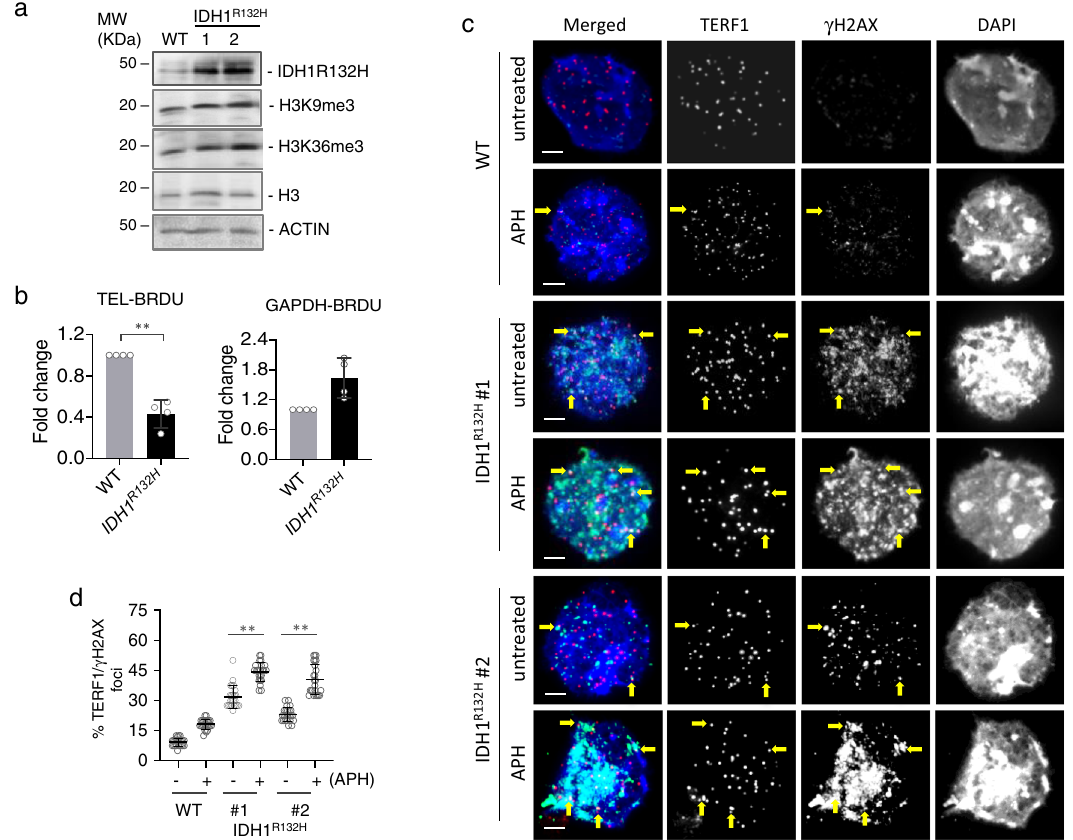
Fig. 5 IDH1 R132H mouse ES cells show replication stress. a Western blot analyses of WT and IDH1 R132H ES cells using antibodies against IDH1R132H, H3K9me3, H3, H3K36me3 and ACTIN. b IP-qPCR analyses of BrdU incorporation at telomeres and Gapdh promoter in WT and IDH1 R132H ES cells ( n = 3 independent experiments). Immuno fl uorescence analyses of TERF1 (red; diluted at 1/500) and γ H2AX (green; diluted at 1/1500) in WT and IDH1 R132H ES cells with and without 1 mM APH treatment for 5 h. Arrows indicate co-staining of γ H2AX and TERF1 ( c ). Percentages of co-localised TERF1 and γ H2AX foci are shown in d . For each cell line, >1500 telomeric or TERF1 foci were counted ( n = 4 independent experiments). Scale bars: 5 μ m. Percentage of co- localised TERF1/ γ H2AX foci are determined as percentages of telomeric foci that co-stained with γ H2AX over the total number of telomeric foci counted. b , d Data are presented as mean values ± SD. ** p < 0.005, Student ’ s t -test with two-tailed distribution. a , c Representative images and blots from at least n = 3 independent experiments. Source data are provided with this